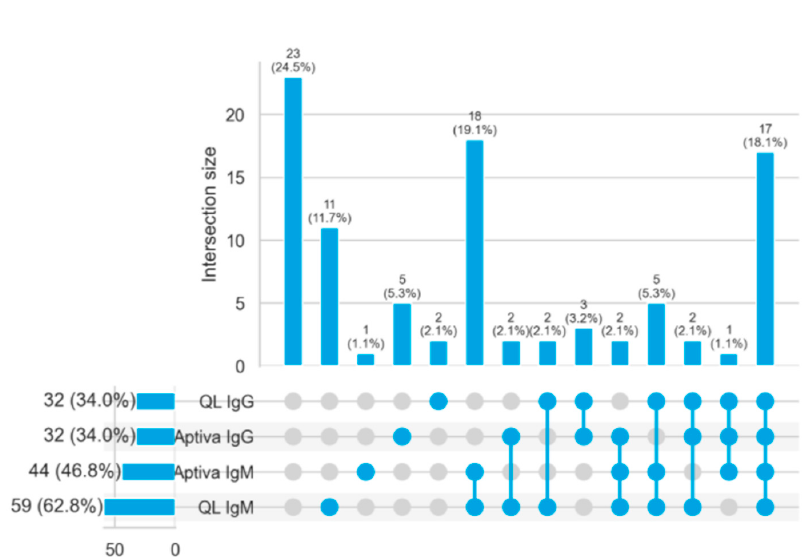
Figure 3. Agreement between ELISA and PMAT for the detection of anti-PS / PT antibodies. ( A ) shows Venn diagrams for IgG and IgM. In ( B ) An Upset plot to visualize the overlap of positivity for aPS / PT antibodies using ELISA and PMAT. aPS / PT means antiphosphatidylserine / prothrombin antibodies; ELISA, enzyme-linked immunosorbent assay.